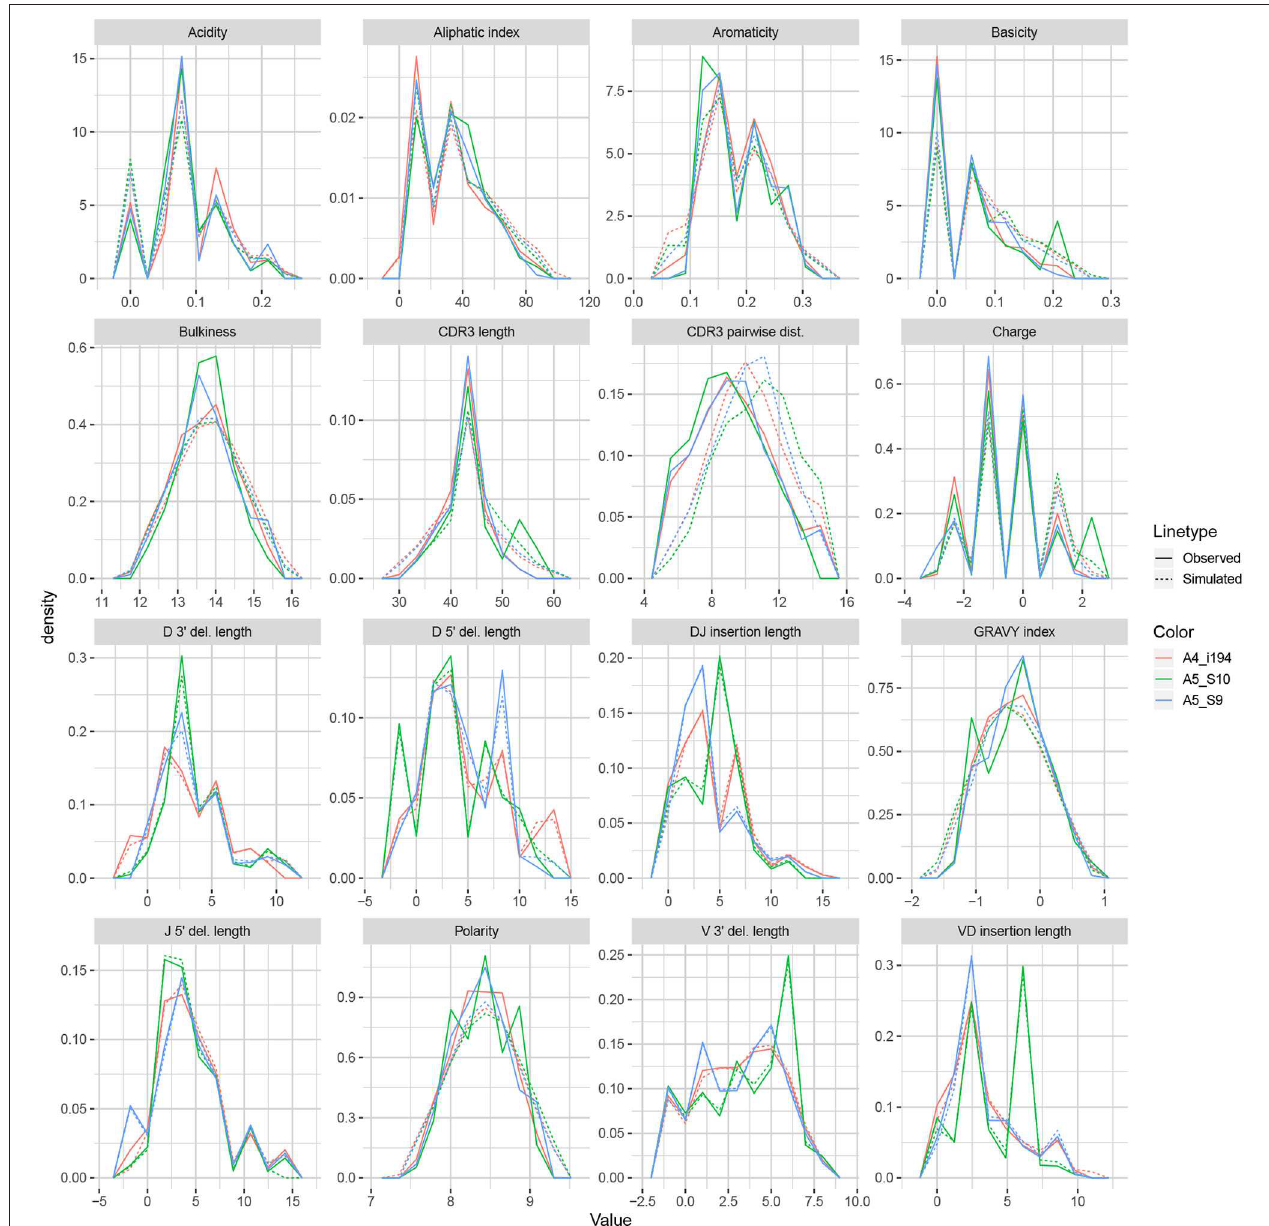
FIGURE 6 | Frequency polygon plots of each univariate summary distribution for the IGoR